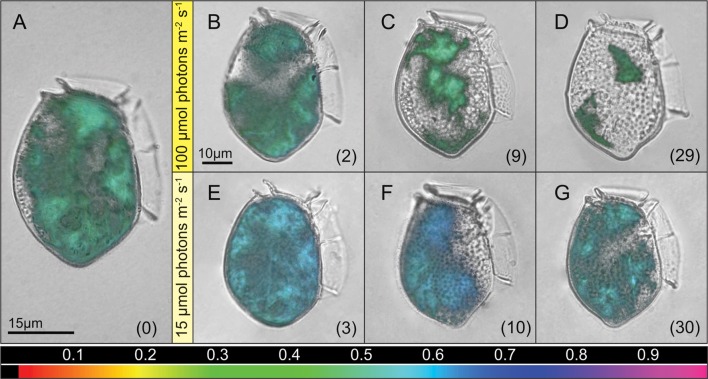
Single cell variable chlorophyll fluorescence imaging. Maximum PSII quantum yield (Fv/Fm) of single D. acuta cells during the starvation experiment. Images display cells at different time points with the quantum yield as an overlay in false color (values corresponding to the color scalebar). A culture representative image for fed cells growing at I100 prior to starvation (A), and culture representative images for starved cells after transfer to irradiances of I100
(B–D) and I15
(E–G). Numbers in brackets presents days of starvation, and time maintained under the given irradiance.